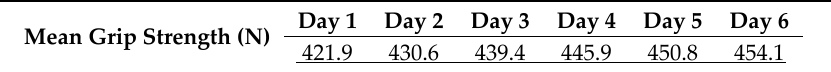
Table 3. Post hoc comparisons for measuring hand grip strength daily before collecting data. *